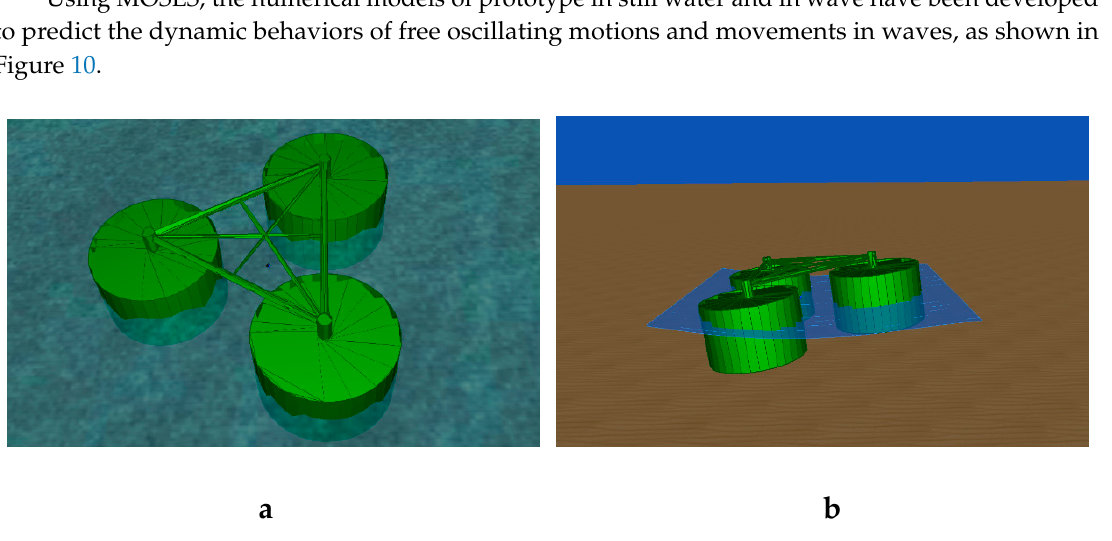
Table 2. Pertinent parameters for the numerical simulations of the prototype in